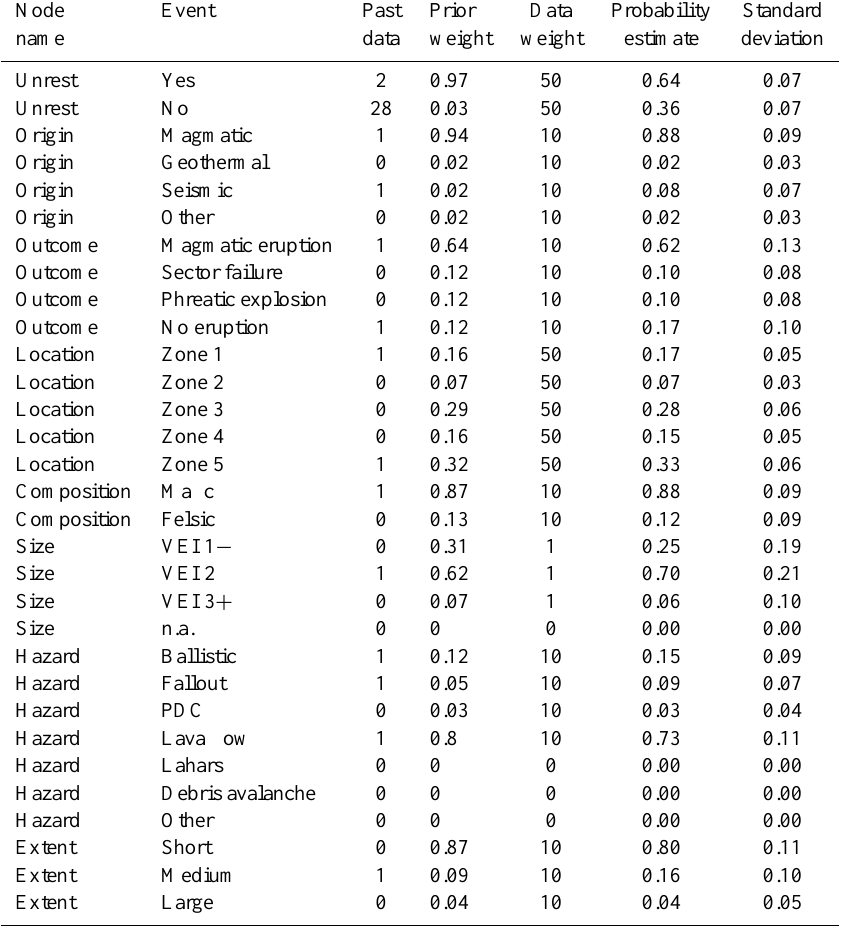
Table 2. Input data for HASSET (columns 1 to 5) and output probability vectors and standard deviations (columns 6 and 7). Prior weights and data weights are estimated using pre-historical data, a priori beliefs and published studies on global volcanic unrest during the last century. Past data are based on the eruptions recorded in the last 600 years, considered as the historical period for the Canary